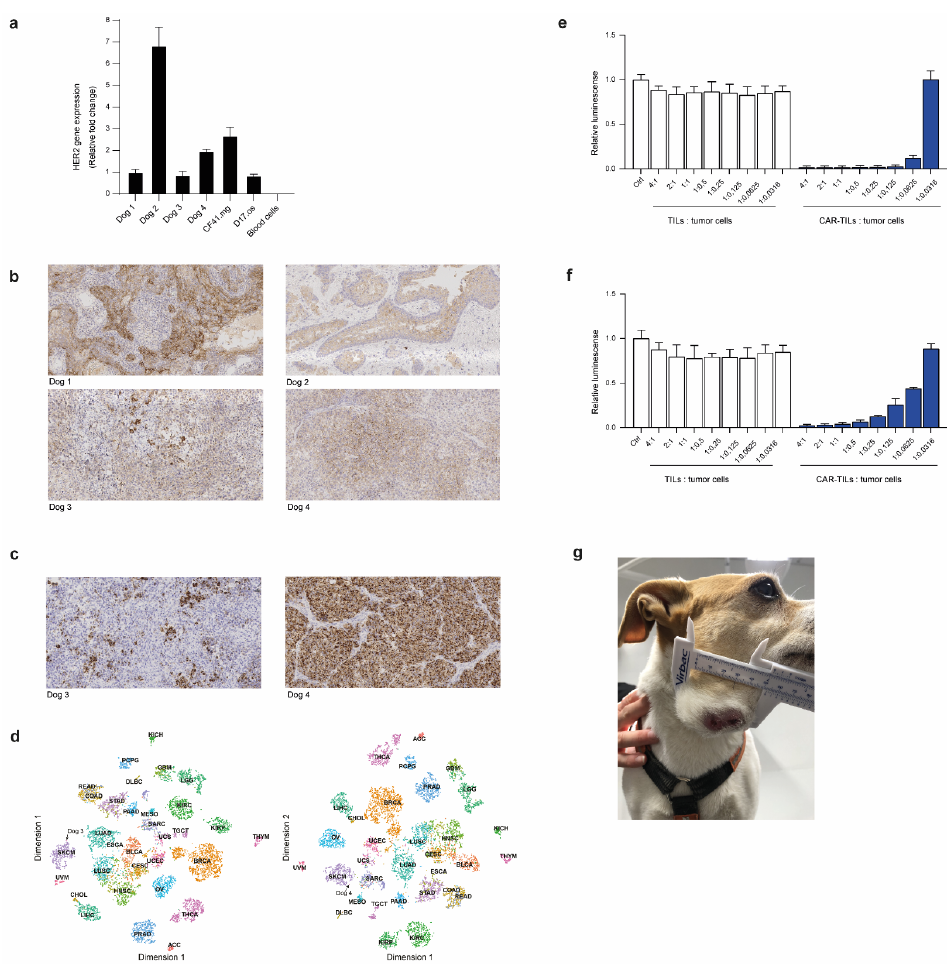
Figure 4. Dog tumor cells express HER2 and can be killed by anti-HER2 CAR-TILs. HER2 expression detected by qPCR ( a ) and immunohistochemistry ( b ) in tumors from four companion dogs (dogs 1-4). Canine cell lines D17.os and CF41.mg and canine PBMC were used as controls in a. ( c ) Expression of human melanoma marker Melan-a in tumors from dogs 3 and 4 with melanoma. ( d ) Classification of canine tumor biopsies from dogs 3 and 4 based on gene expression relative to TCGA cohort of >10,000 human tumor samples from 32 cancer types. The similarities between canine melanoma and samples in TCGA were visualized using tSNE dimensionality reduction. SKCM: melanoma cases. ( e , f ) TILs and mRNA electroporated CAR-TILs from dog 3 were co-cultured with the canine cell lines CF41.mg ( e ) and D17.os ( f ) for 24 h. The experiment was performed twice and representative data ( n = 3, data ± SD) from one experiment are shown. ( g ) Photograph of Dog 3 with metastatic oral malignant melanoma enrolled in the FIDO trial evaluating the safety of CAR-TIL treatment in companion